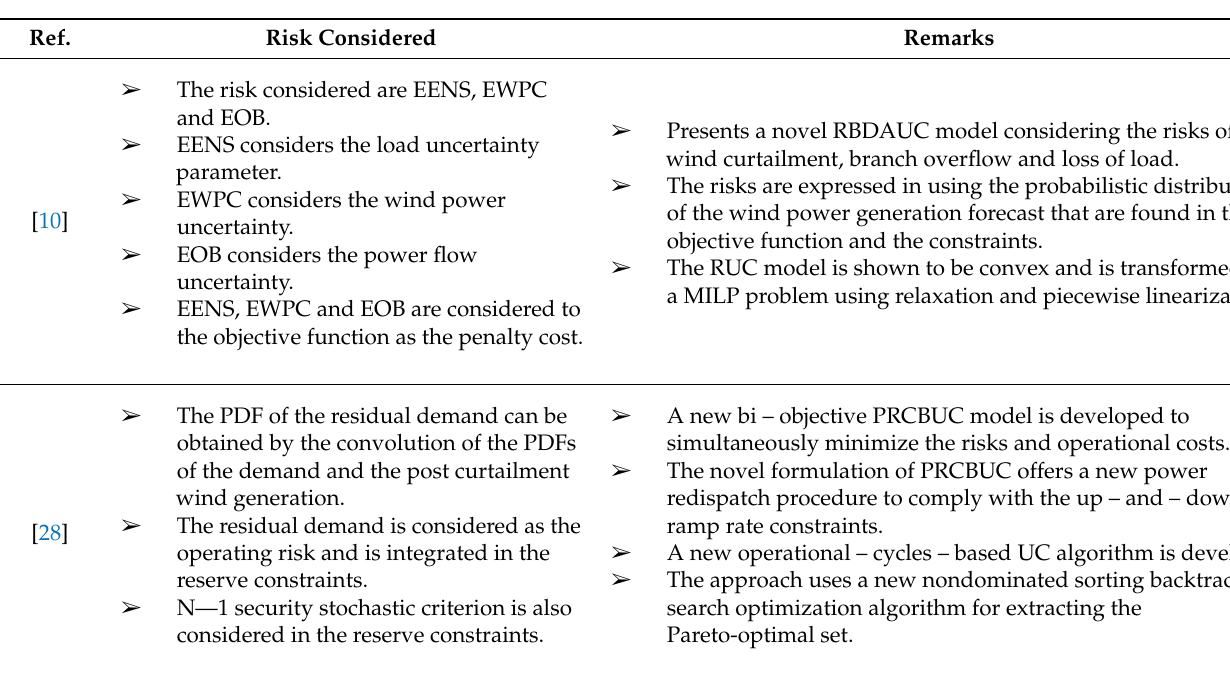
Table 14. Studies In Which Risk-Based Optimization Is